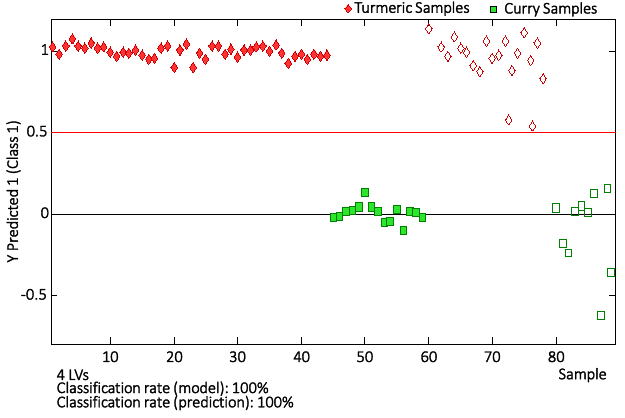
Figure 6. Class prediction plot for turmeric vs. curry samples. Filled and empty symbols correspond to calibration and validation sets, respectively. Four LVs were used to generate the model. All the results obtained by PLS-DA demonstrated the applicability and good performance of non-targeted UHPLC-HRMS fingerprints as sample chemical descriptors for the characterization, classification, and authentication of curry and turmeric samples.